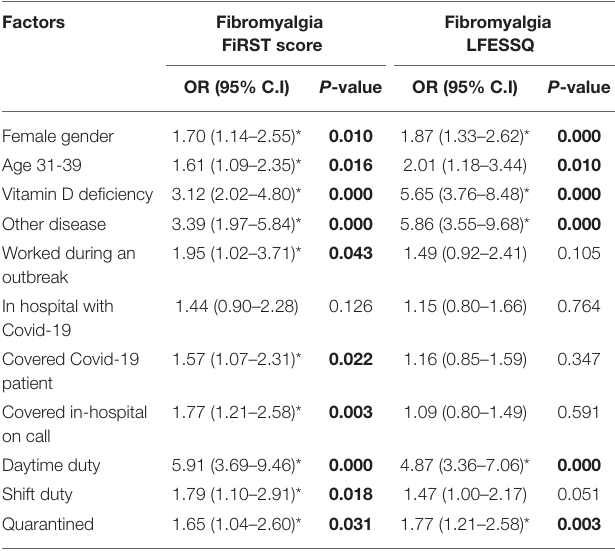
TABLE 5 | Predictors of fibromyalgia associated with the healthcare service during Covid-19 pandemic.